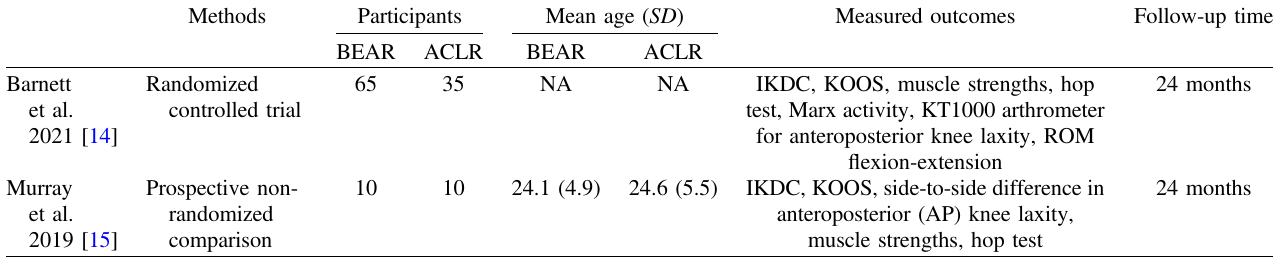
Table 1. Main characteristics of the included